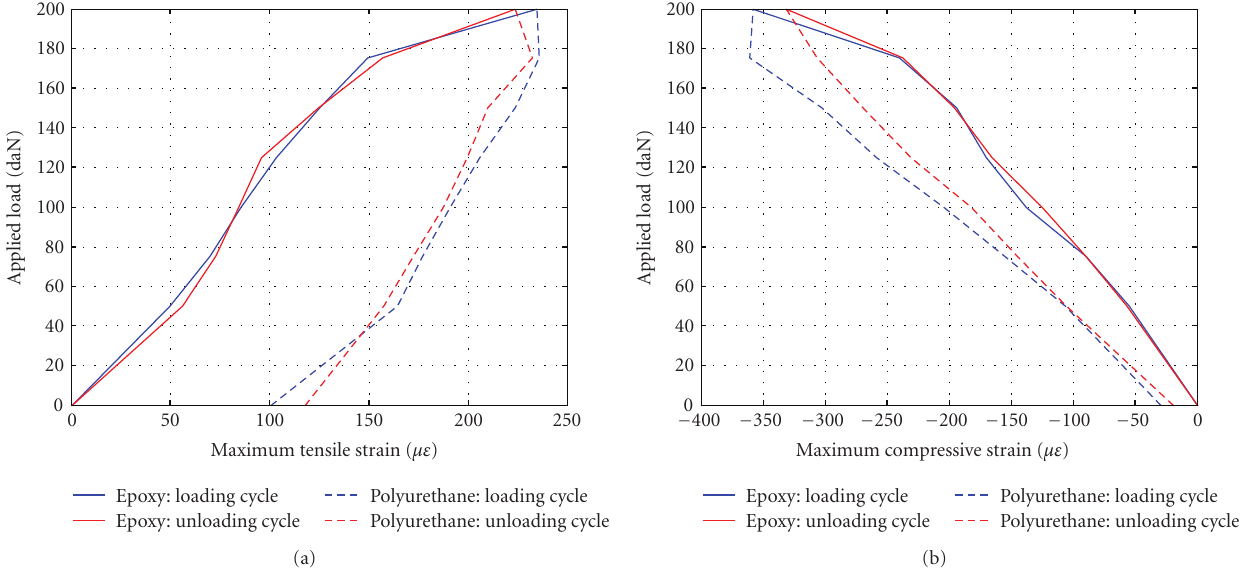
Figure 6: (a) Applied load versus maximum tensile strain; (b) applied load versus maximum compressive strain.